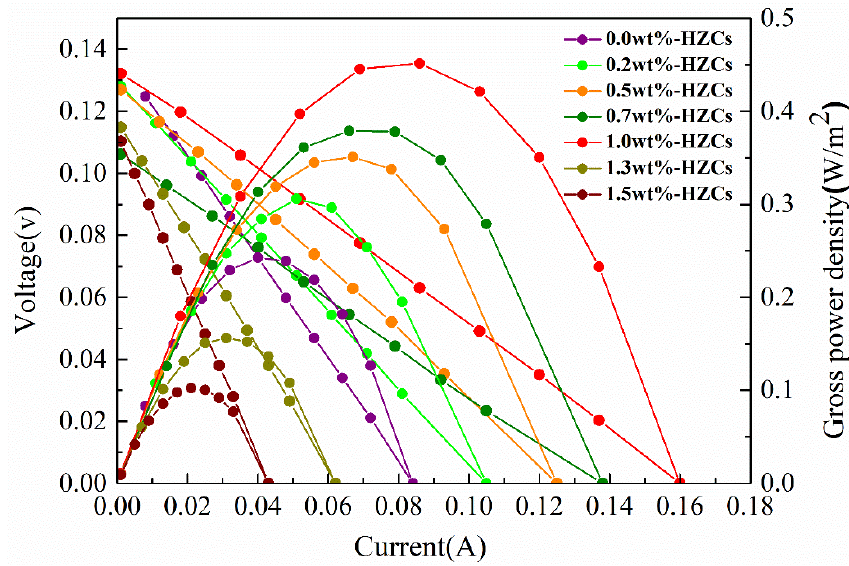
Figure 10. Power density curves obtained from the nanocomposite membrane at different HZC